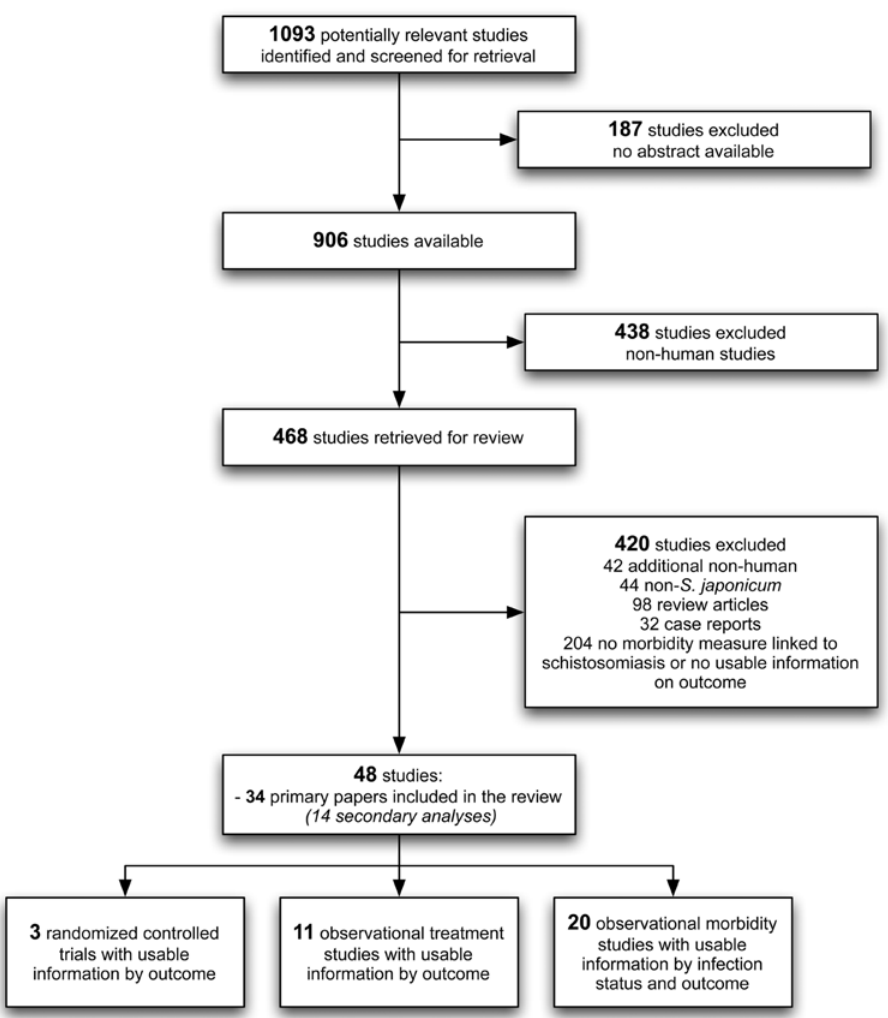
Figure 1. Literature search strategy. Shown is a diagrammatic representation of the retrieval strategy used for identifying and selecting studies for inclusion in the final analysis.